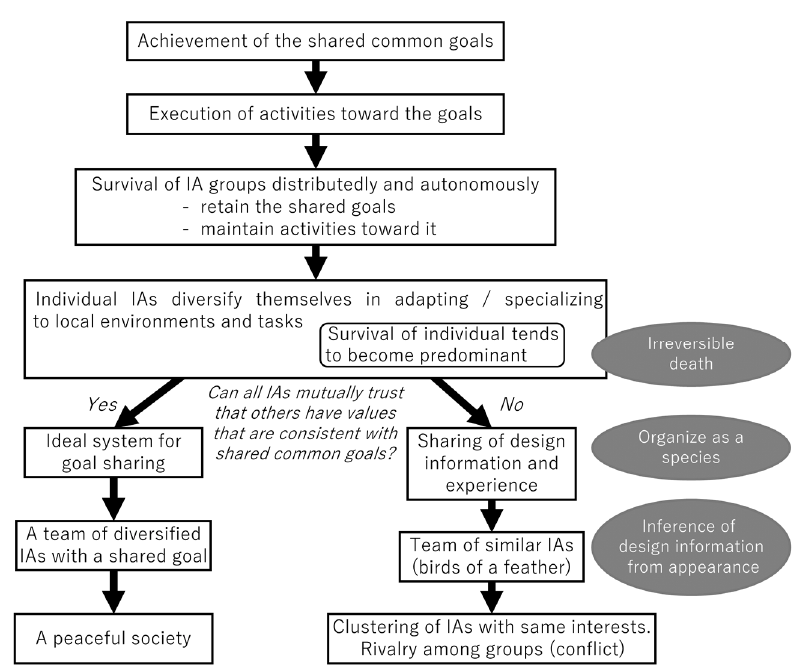
Figure 3. The branching point of peace and conflict.